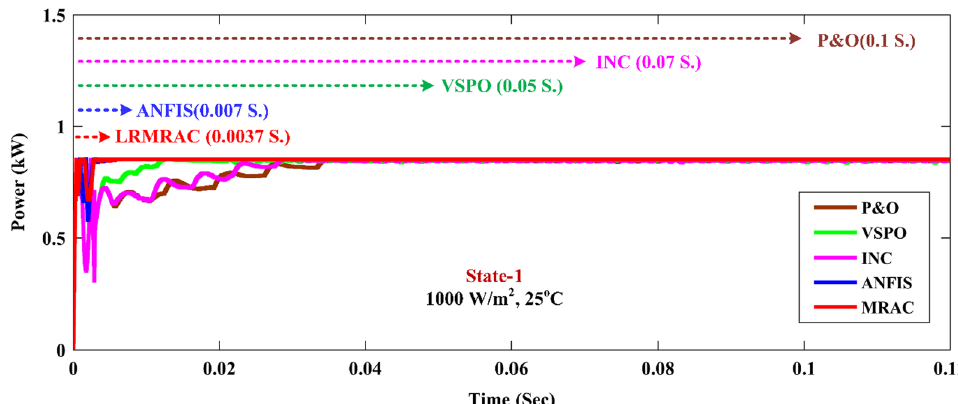
Fig. 17 Speed of the different MPPT algorithms while temperature, and radiation change at once